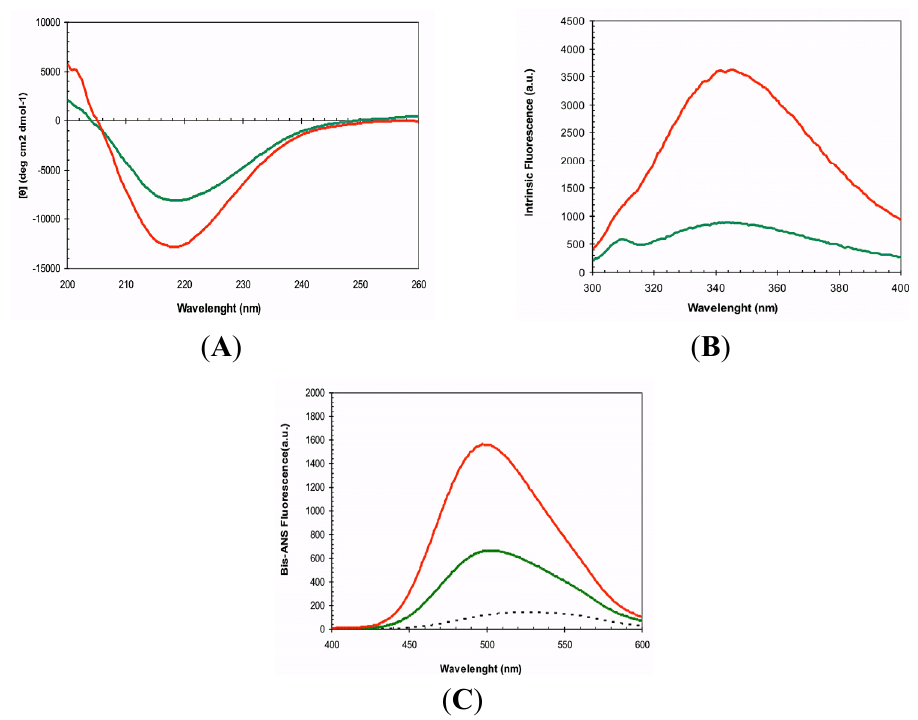
Figure 5. TFE dependence of the conformational properties of URN1-FF fibrils. The protein domain was incubated at pH 2.5 and 100 μ M for at least 21 days. ( A ) Far-UV CD spectra using a final concentration of 20 μ M; ( B ) Tryptophan intrinsic fluorescence; ( C ) Fluorescence emission spectra of bis-ANS (25 µM) collected in the absence (dotted line) and in the presence of fibrils (10 µM). In all the cases, f0% fibrils in red and f15% fibrils in green.